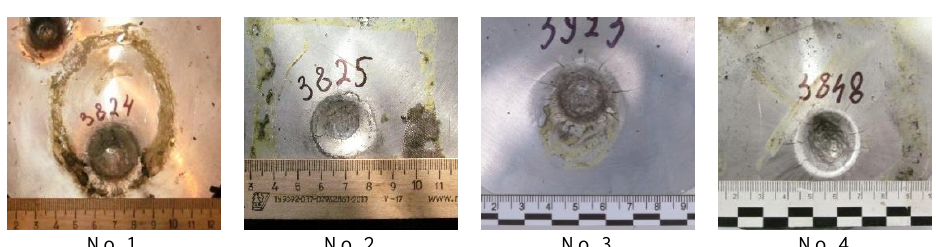
No. 1 Fig 5. Crater in the barrier-“witness” after impact in the first series of